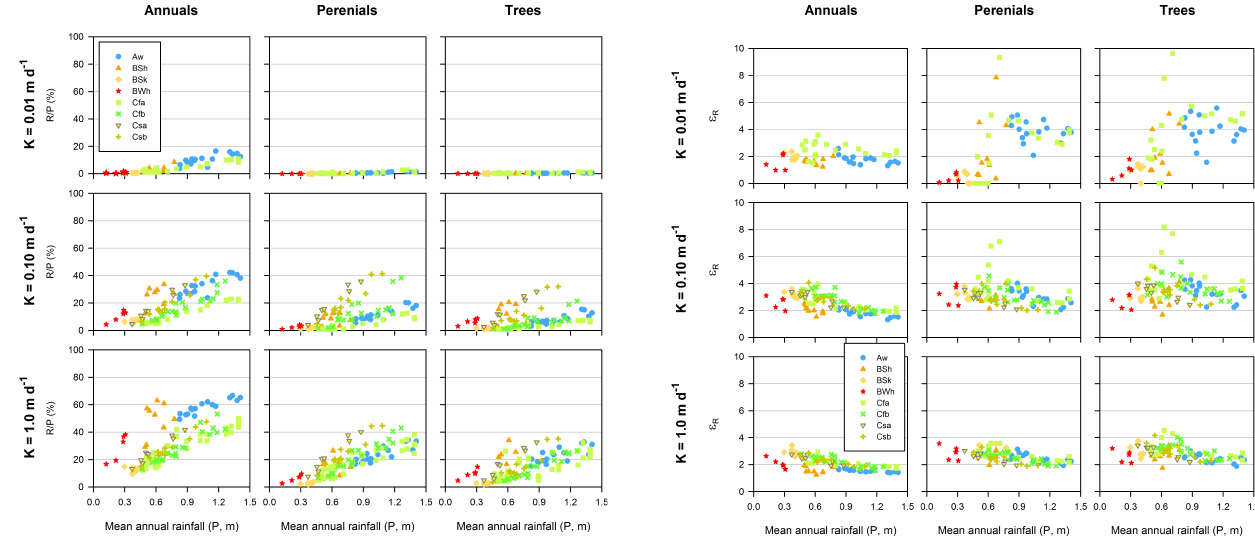
Fig. 8. Scatter plots of mean annual rainfall ( P ) and recharge elas- ticity ( e R ) for all modelled locations within considered climate types, under soil with selected hydraulic conductivities and vege- tation types.